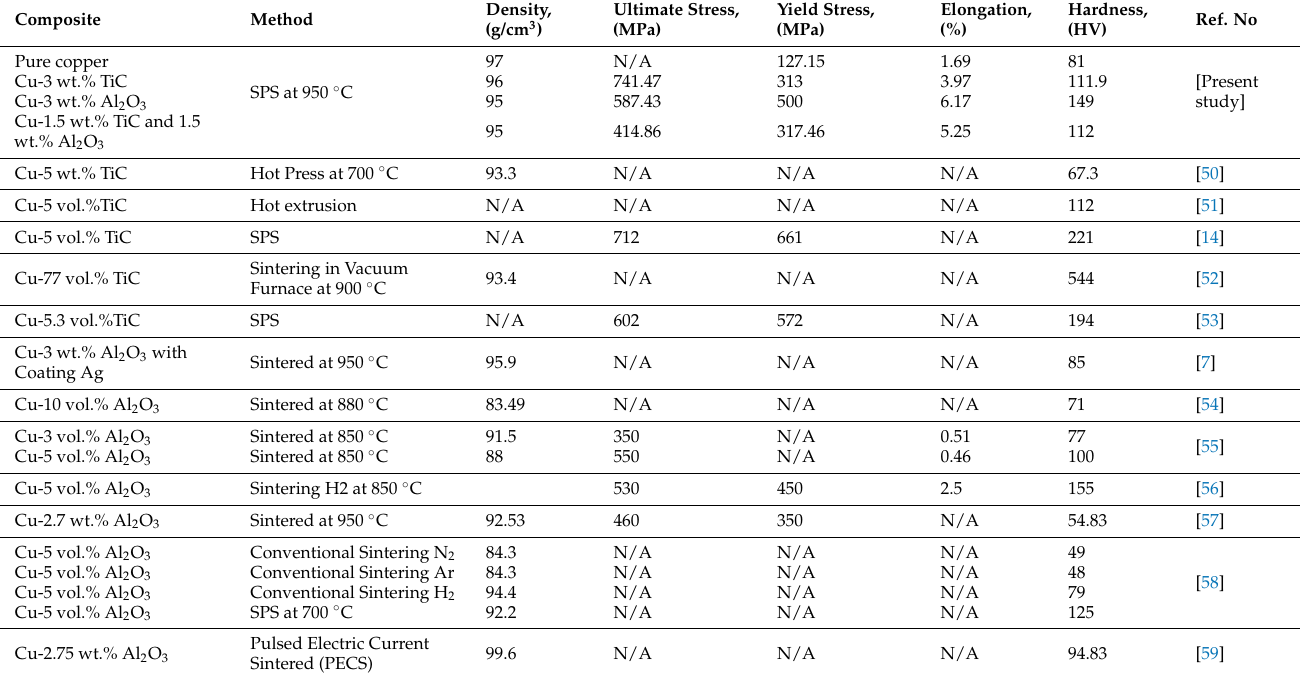
Table 2. Comparing the present study with literature data of previous